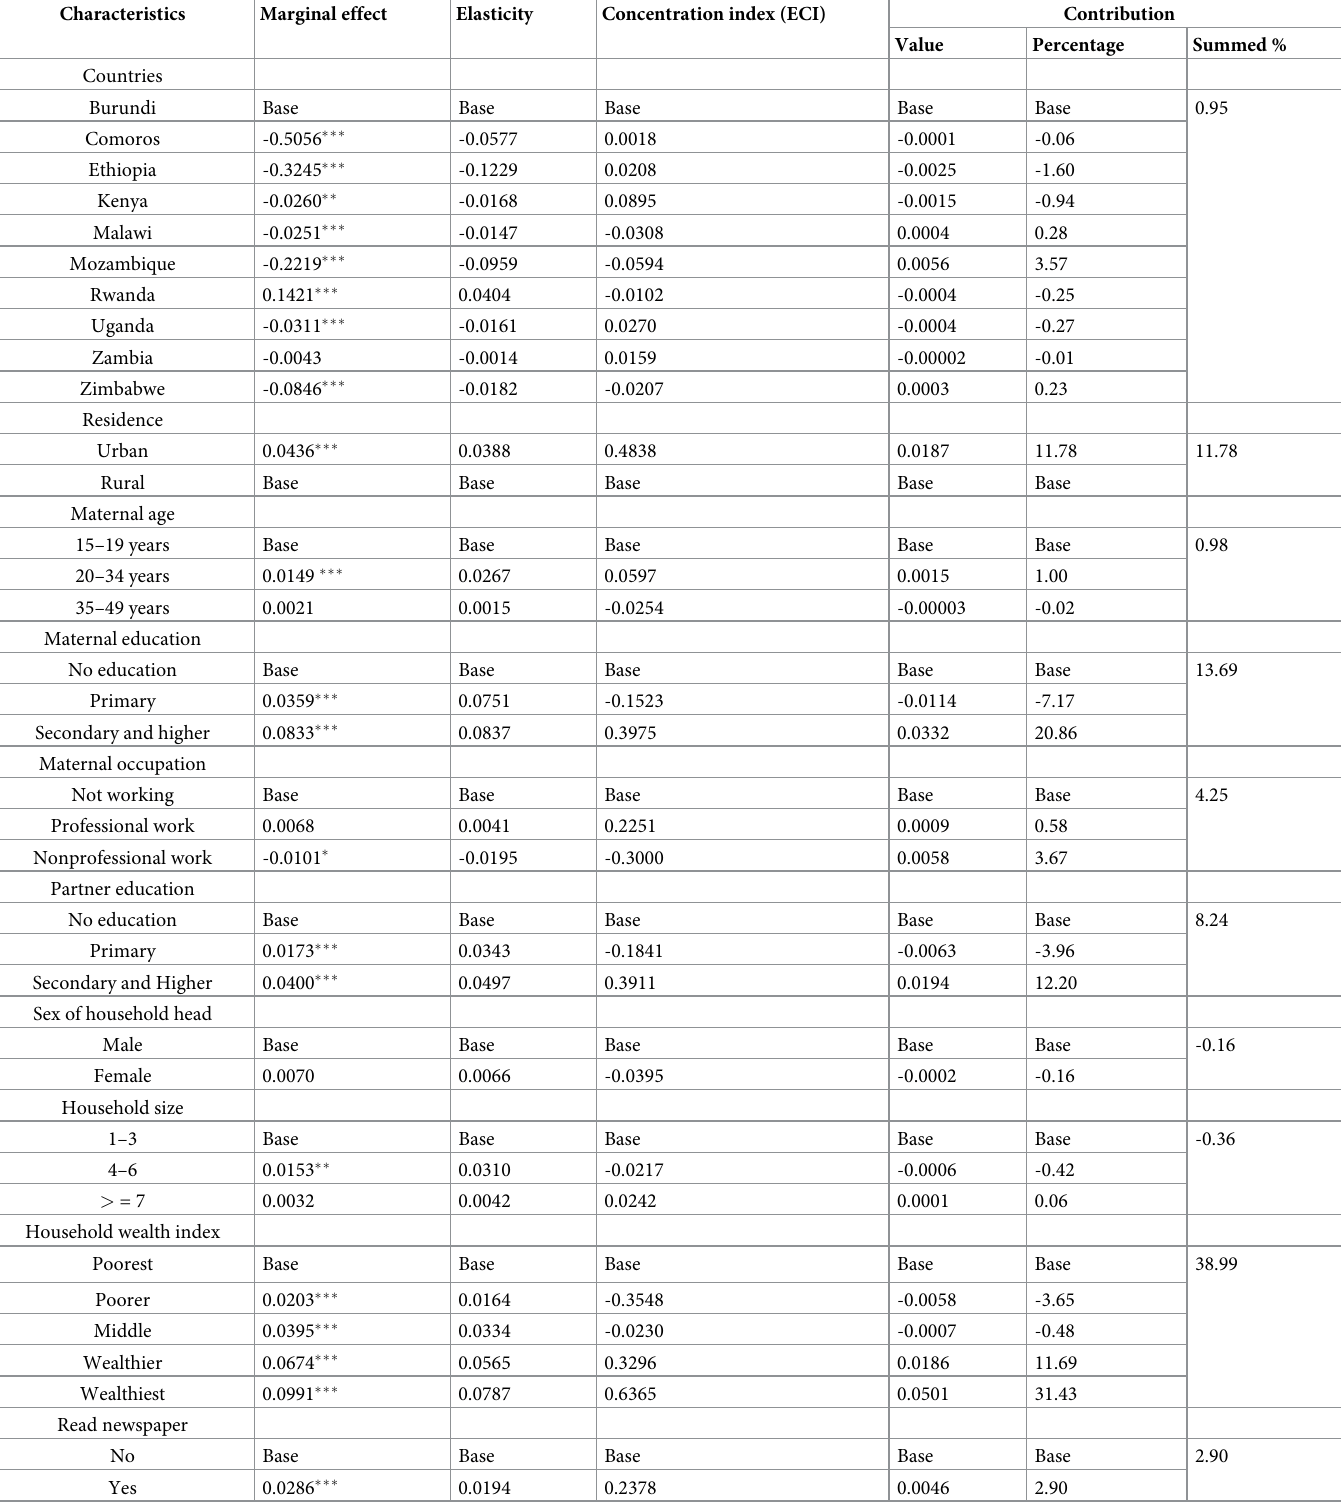
Table 3. A decomposition analysis of socioeconomic inequalities in prenatal HIV testing for PMTCT in East